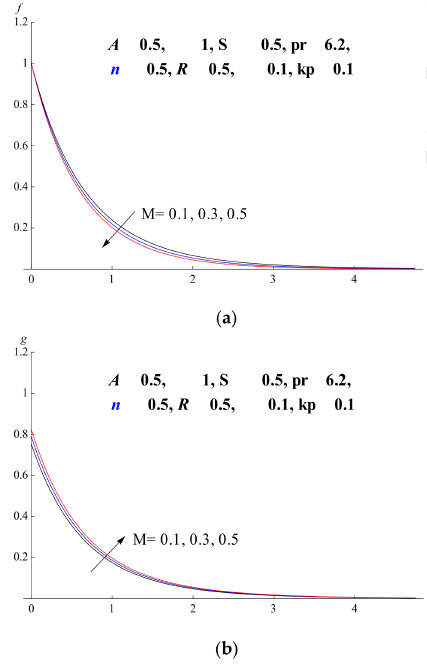
Figure 7. Influence of the magnetic parameter ( M). ( a ) Velocity profile and ( b ) angular velocity